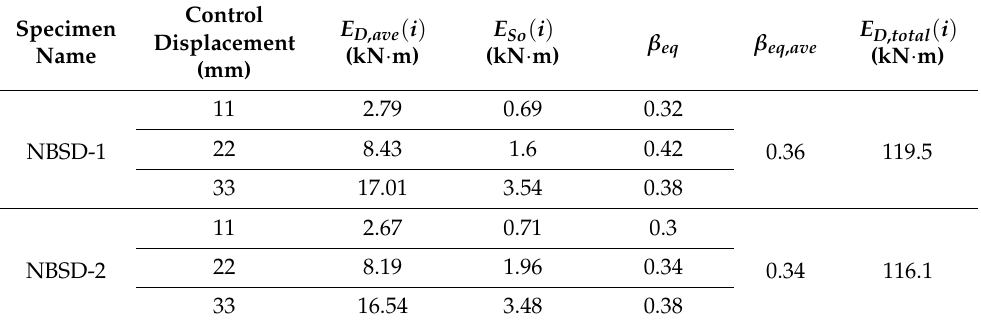
Table 4. Equivalent damping ratios and cumulative energy dissipation of the NBSD-based seismic control